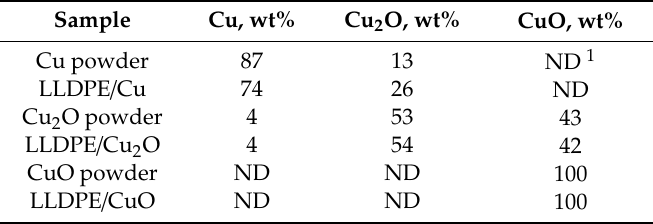
Table 1. Sample composition obtained by relative intensity ratio (RIR)